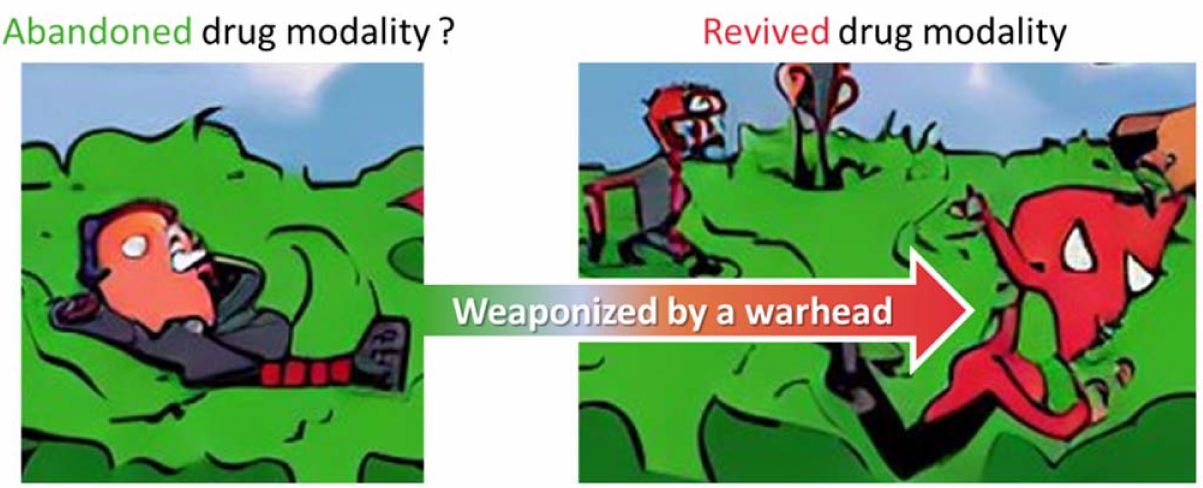
Figure 9. Weaponized and revived aptamer: From zero to hero. A conceptual summary of how the abundance of aptamers reported in the literature, but currently abandoned from clinical translation, could be transformed into potentially useful drugs by warhead introduction, rendering them to